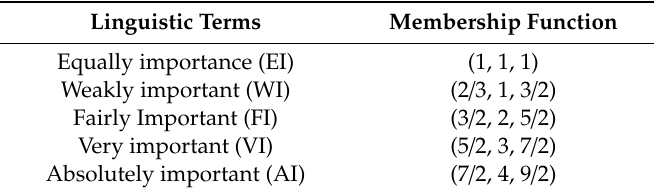
Table 2. Transformation instructions of linguistic variables of